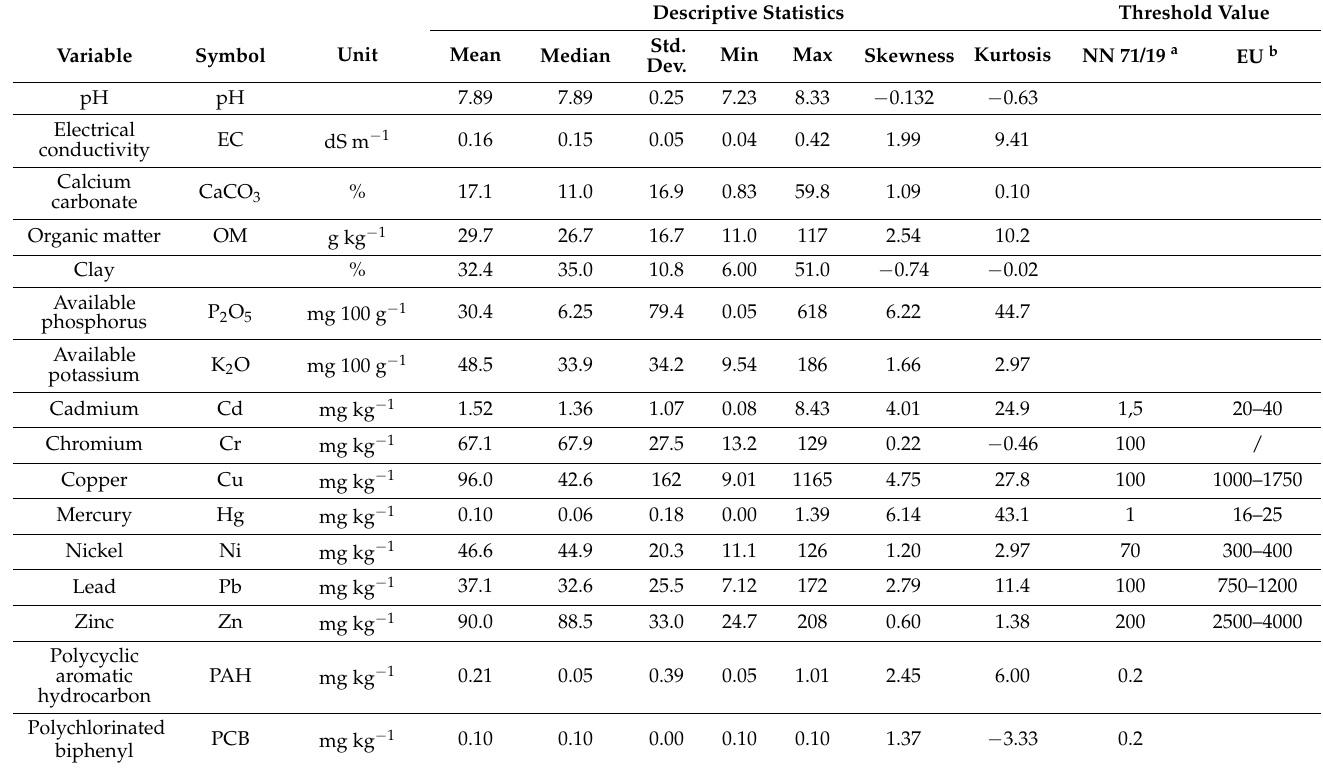
Table 4. Basic statistics on soil properties, heavy metal concentrations, polycyclic aromatic hydrocarbons (PAHs) and polychlorinated biphenyls (PCBs) (N = 68). Threshold values set by legislation are given. Descriptive Statistics Threshold